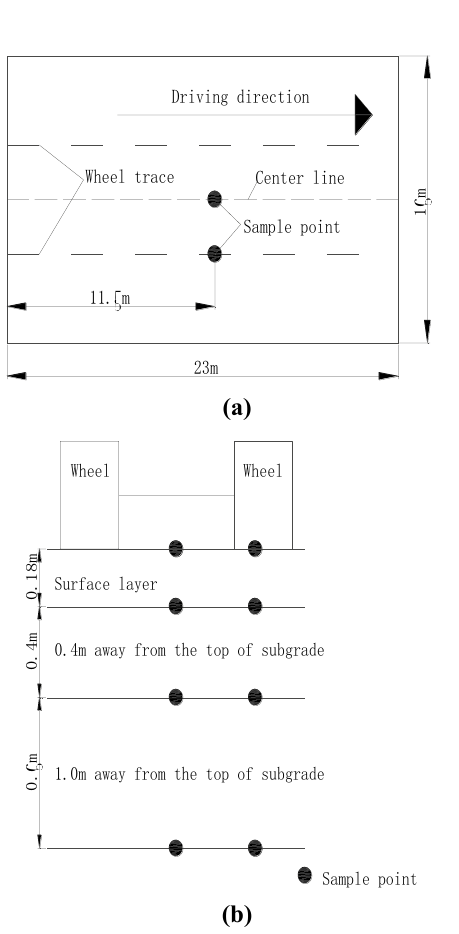
Fig. 2 Layout of sampling points layout of a planar graph and b cross-sectional